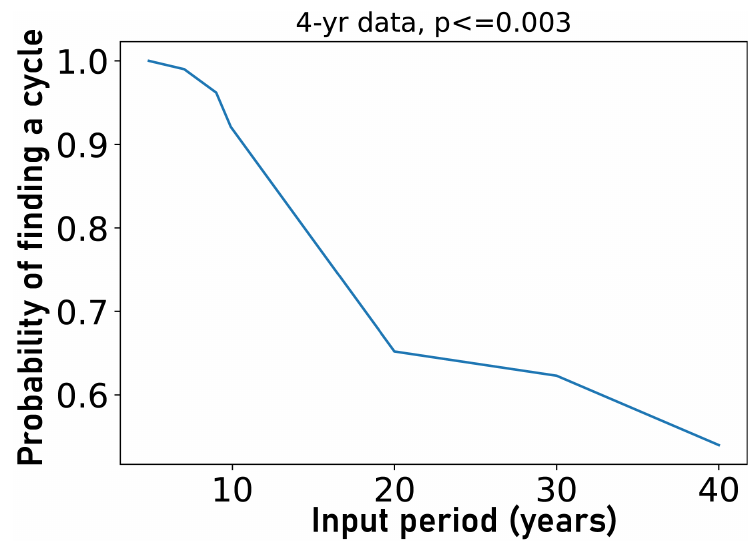
Figure 12. This is the probability to find a magnetic activity cycle using our smoothness metric. As noted in Section 3.1, we accept a signal as a detected cycle when the p -value is less than 0.003. We randomly select a 4 years segment from the synthetic light curve and apply our smoothness metric (this length is the same as that which we use when analyzing our sample stars from Kepler). Each input period has 100 tests.